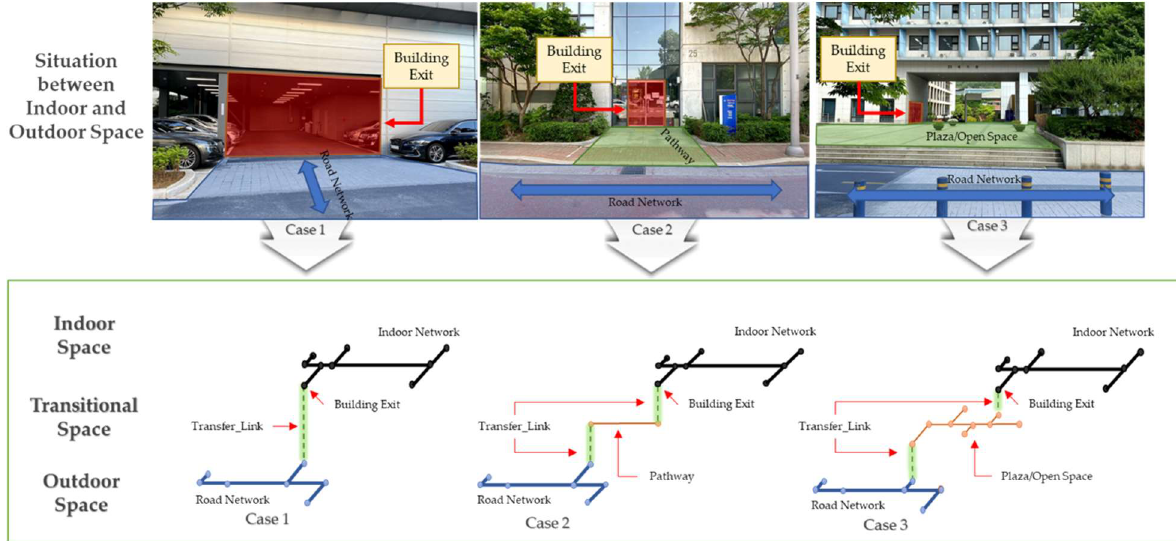
Figure 5. Representing connections between indoor and outdoor space for different indoor and outdoor connection cases at different levels of abstraction.